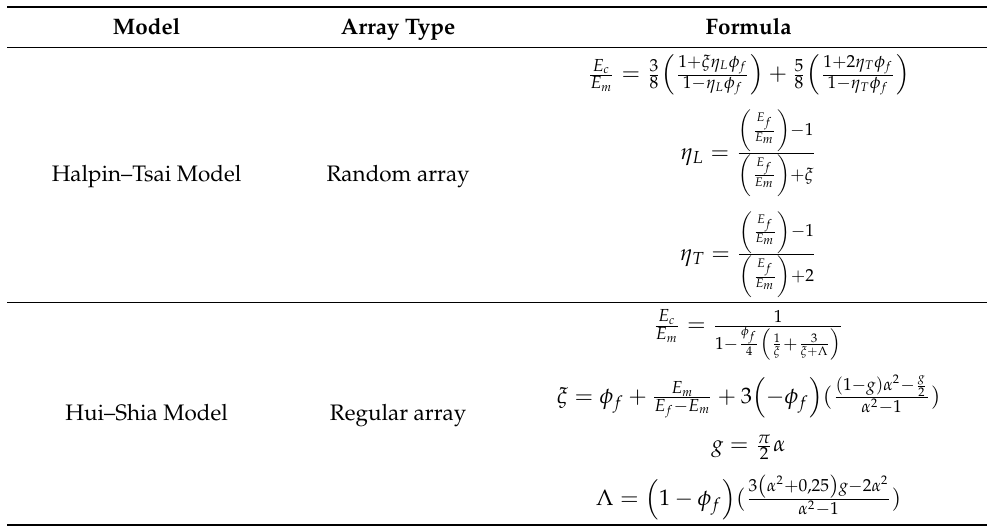
Table 5. Mechanical models